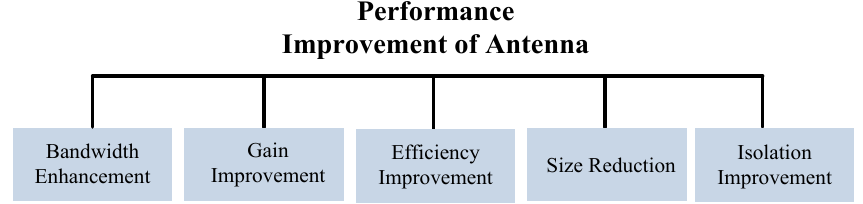
Figure 3. Various performance improvements of antennas by using